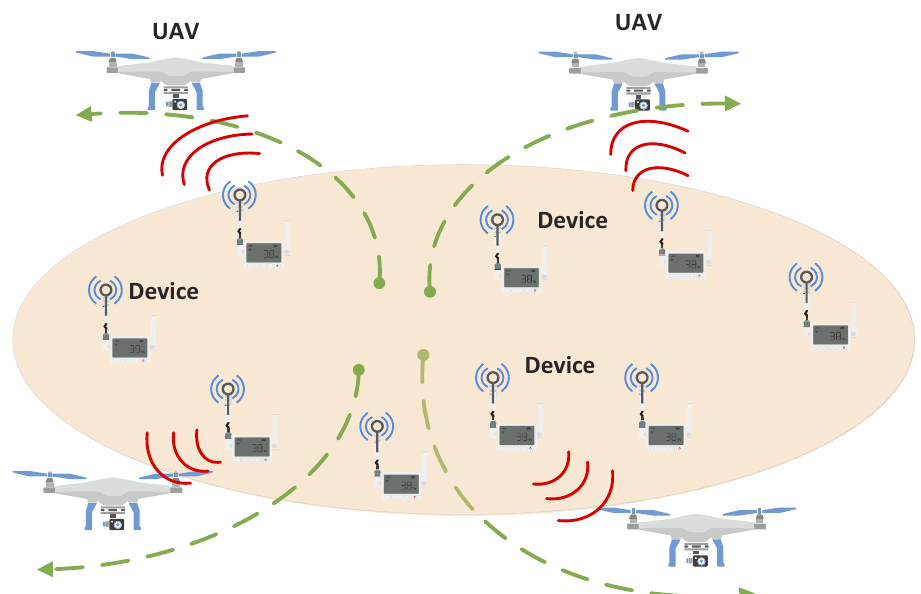
Figure 1. The multi-unmanned aerial vehicle (UAV)-enabled data collection scenario with channel interference, where multiple UAVs are flying in the sky to collect data from served devices and numerous sensors distributed over an area at fixed locations during a certain period. The dotted green lines represent the trajectories of the